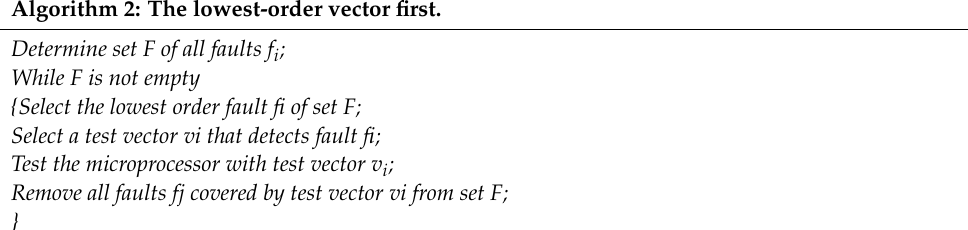
Algorithm 2: The lowest-order vector first.